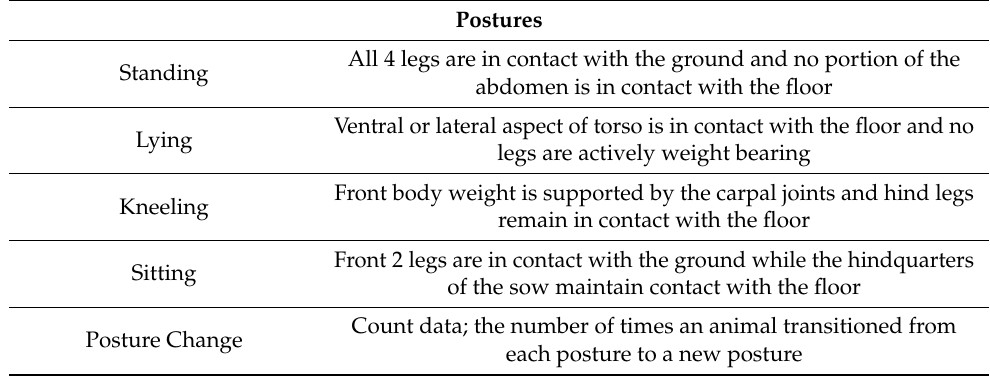
Table 2. Ethogram of behaviors observed during scan observations 1